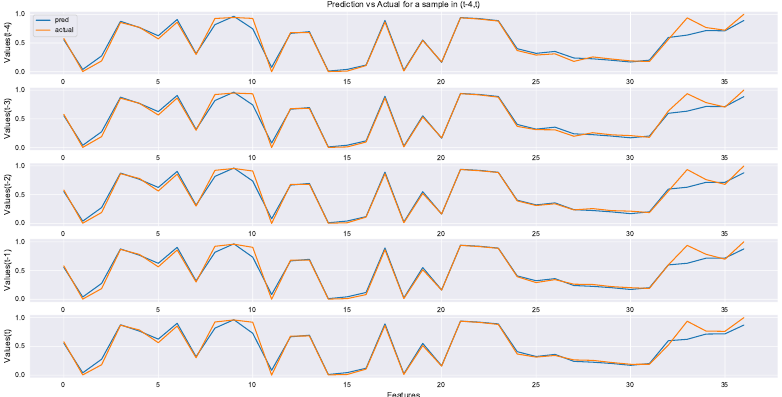
Figure 13. Five-time-step reconstruction of each feature in the pre-training